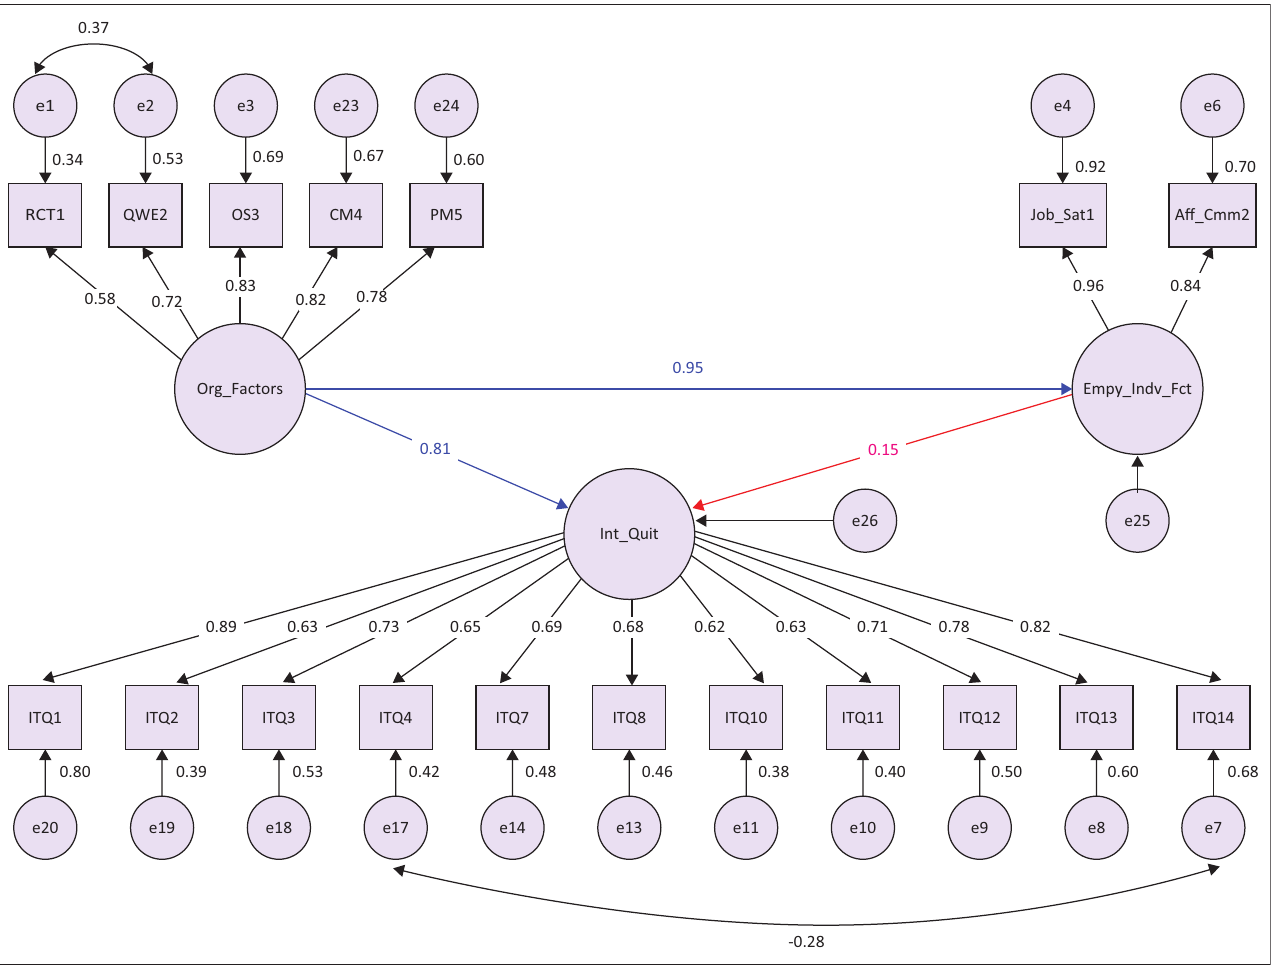
FIGURE 4: The structural